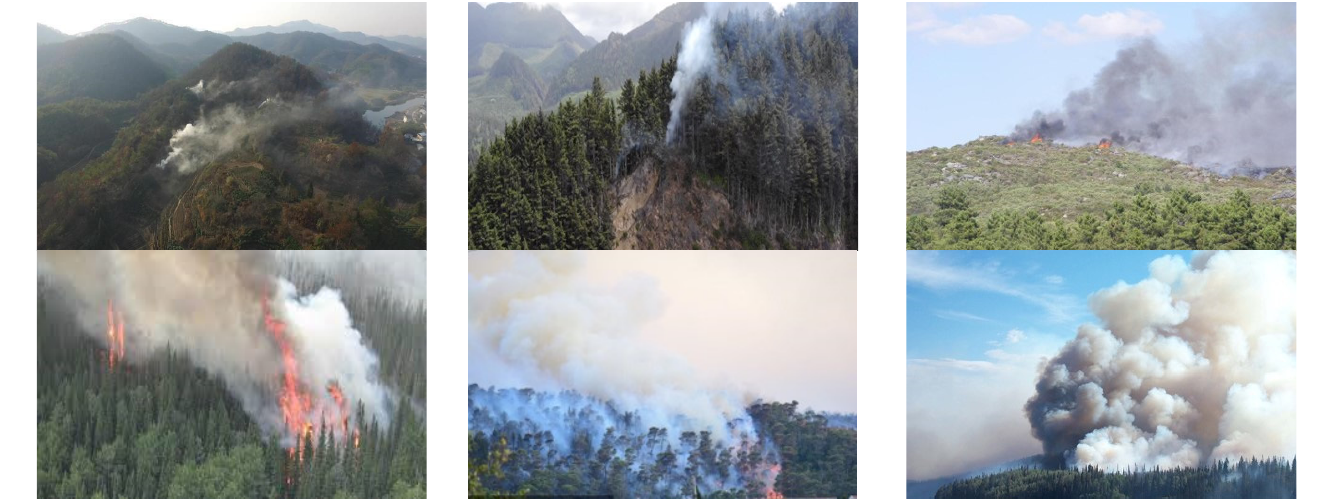
Figure 1. Samples of the FFS dataset (images show smoke objects at different scales, images of first row shows light smoke, the second row shows dense smoke).